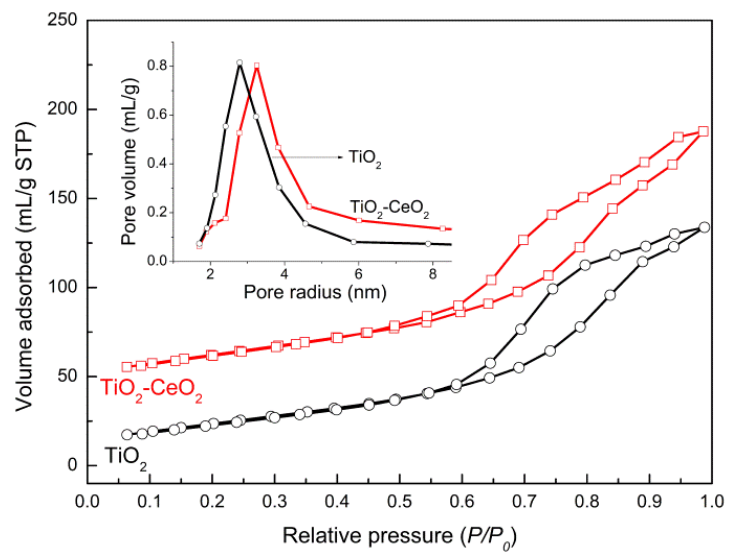
Figure 5. Nitrogen adsorption-desorption isotherms and pore size dispersion (inset) of the TiO 2 and TiO 2 -CeO 2 catalysts. Table 3. The texture properties of TiO 2 and TiO 2 -CeO 2